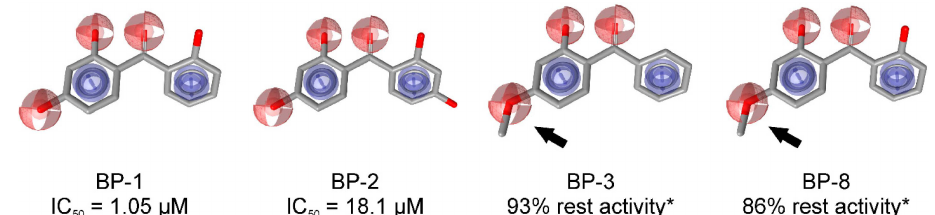
Figure 18. SAR analysis revealed that the etherification of the hydroxyl group (as indicated by the arrows) was responsible for the loss of activity observed for BP-3 and BP-8 [74]. * Remaining enzyme activity at a compound concentration of 20 µ M compared to vehicle